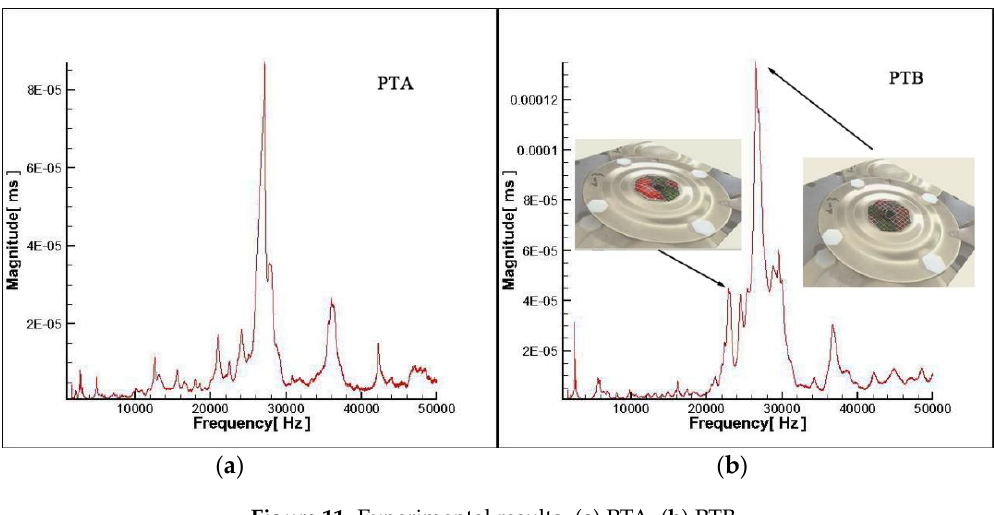
Figure 11. Experimental results. (a) PTA. (b) PTB.